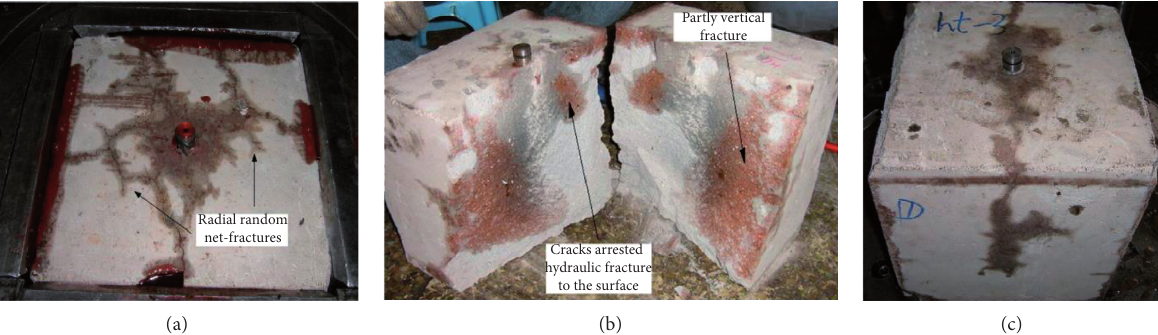
Figure 9: Photos of hydraulic fractures [119]. (a) Radial random net-fractures at the horizontal stress difference of 1. (b) Partly vertical fracture with random branches at the horizontal stress difference of 2. (c) Dominating fracture with multiple branches at the horizontal stress difference of 10.